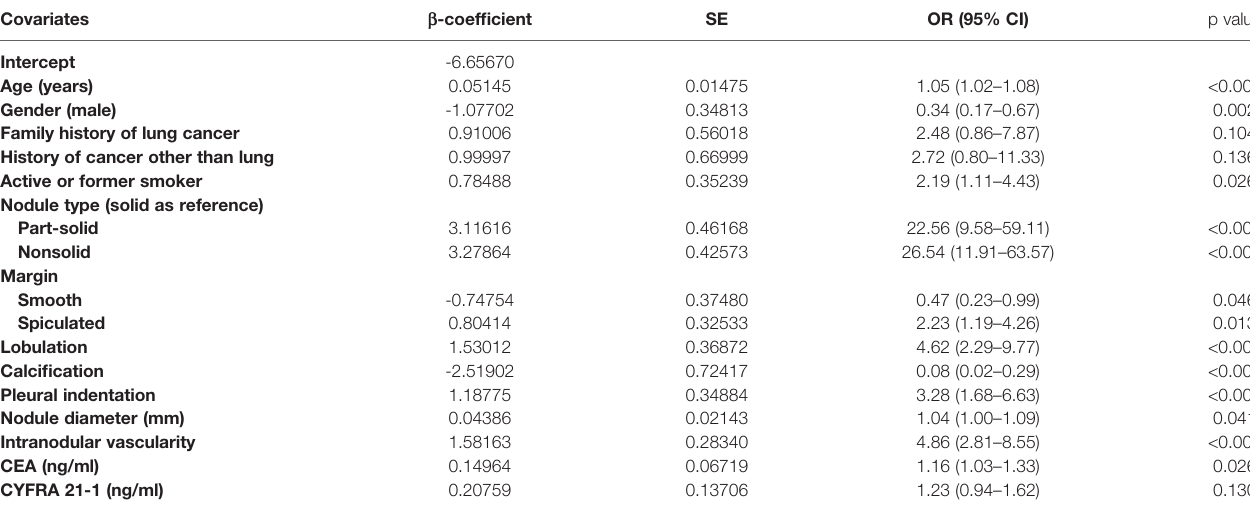
TABLE 4 | Characteristics for covariates in the fi nal model (M1) for the probability of lung cancer in pulmonary nodules. Covariates b -coef fi cient SE Intercept